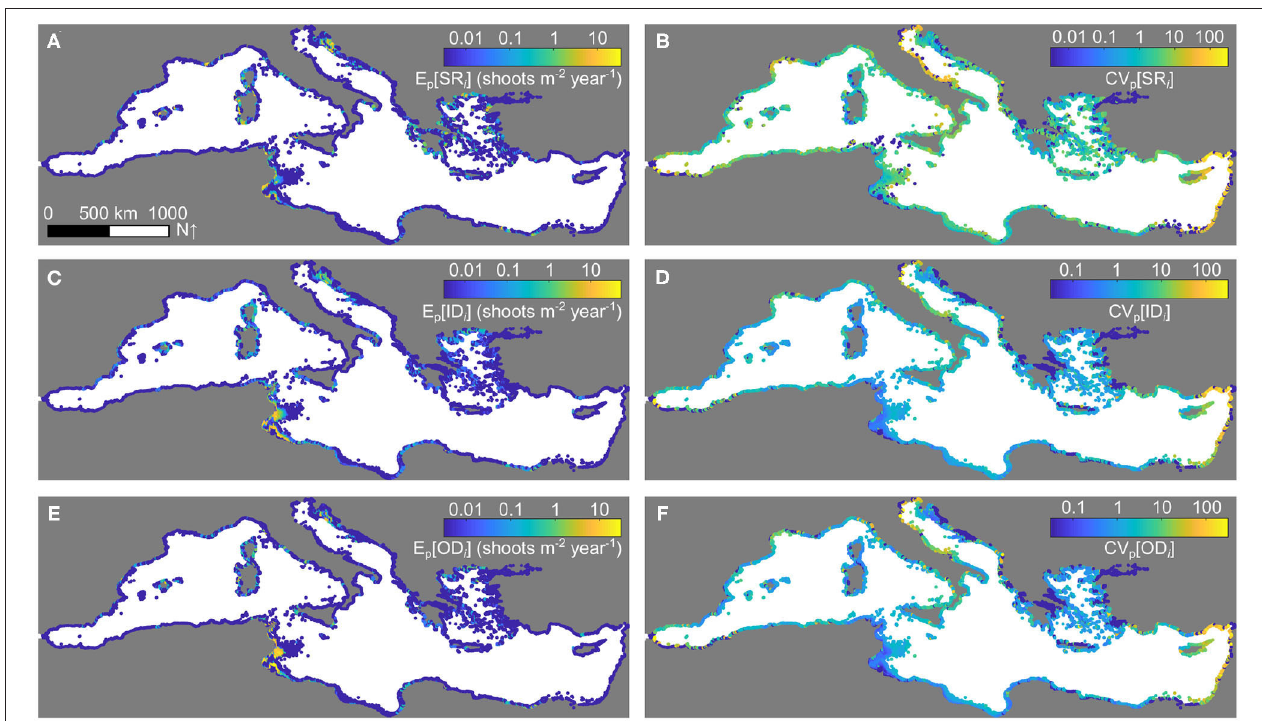
FIGURE 3 | Realized connectivity patterns for P. oceanica evaluated from the metapopulation model. (A) Pooled average and (B) coefficient of variation of self-retention. (C) Pooled average and (D) coefficient of variation of indegree connectivity. (E) Pooled average and (F) coefficient of variation of outdegree connectivity. All quantities refer to the simulation of Figure 2 and are shown in log 10 scale.